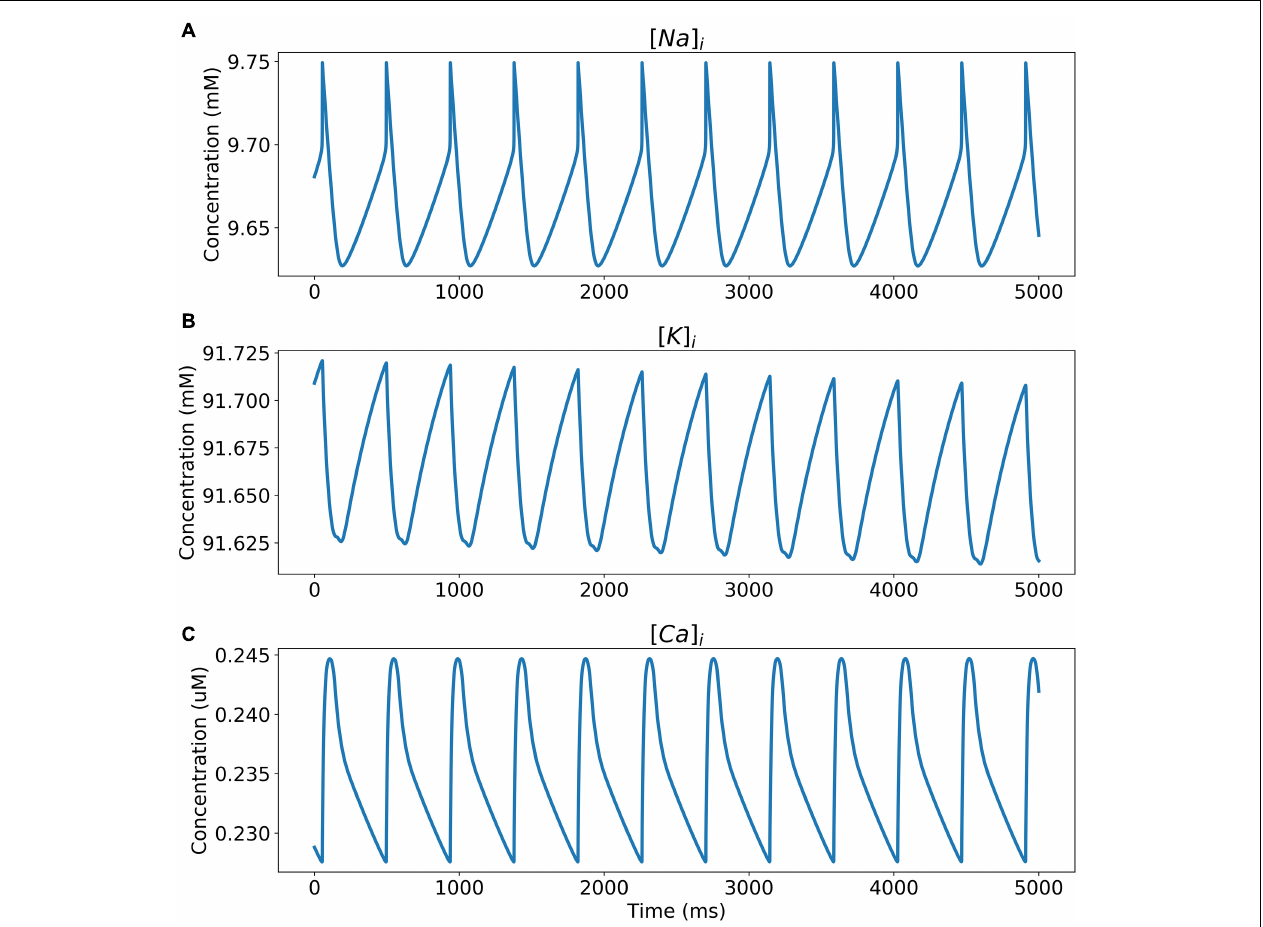
FIGURE 7 | Intracellular ionic concentrations. (A) [Na + ] i , (B) [K + ] i , and (C) [Ca 2 + ] i during spontaneous